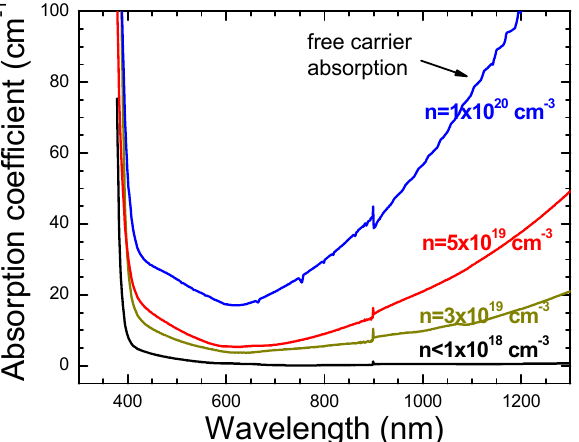
Figure 6. The absorption coefficient determined in the visible and near-infrared spectral region for n-type GaN substrates dedicated for light emitters.